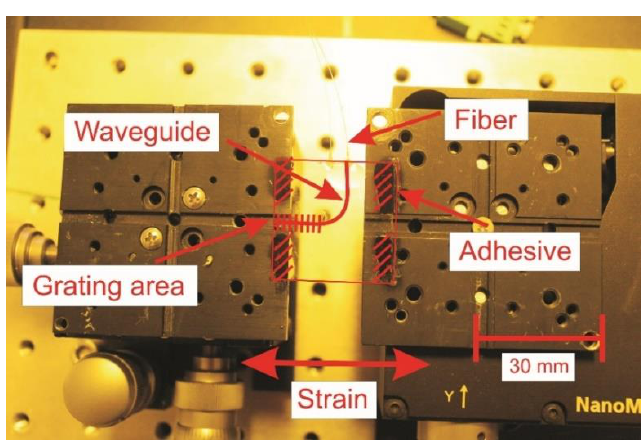
Figure 5. Experimental setup for the strain sensitivity investigation. The dimensions of the sensor plate are 30 × 30 mm. The strain is applied in the longitudinal direction of the Bragg grating in ten incremental steps of 3 µm each. The substrate of the sensor is fixed at its outer edges to the translational stages. The relative lengthening is expressed in microstrain, and therefore ∆ l is set in micrometers, while the total length L without strain is given in meters. The abovementioned dimensional changes in the conducted strain experiment result in a maximum relative strain of 1666 µ m / m.